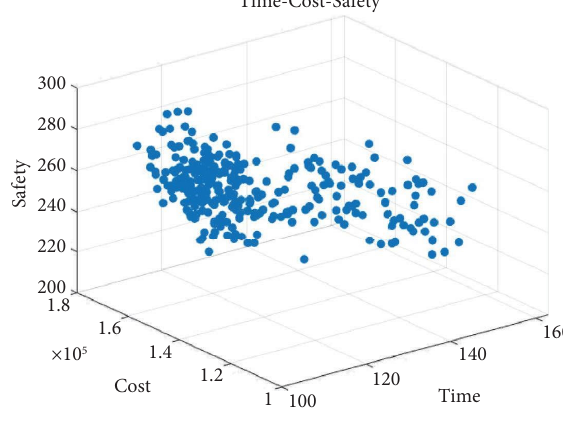
Figure 22: Time-cost-safety trade-of.